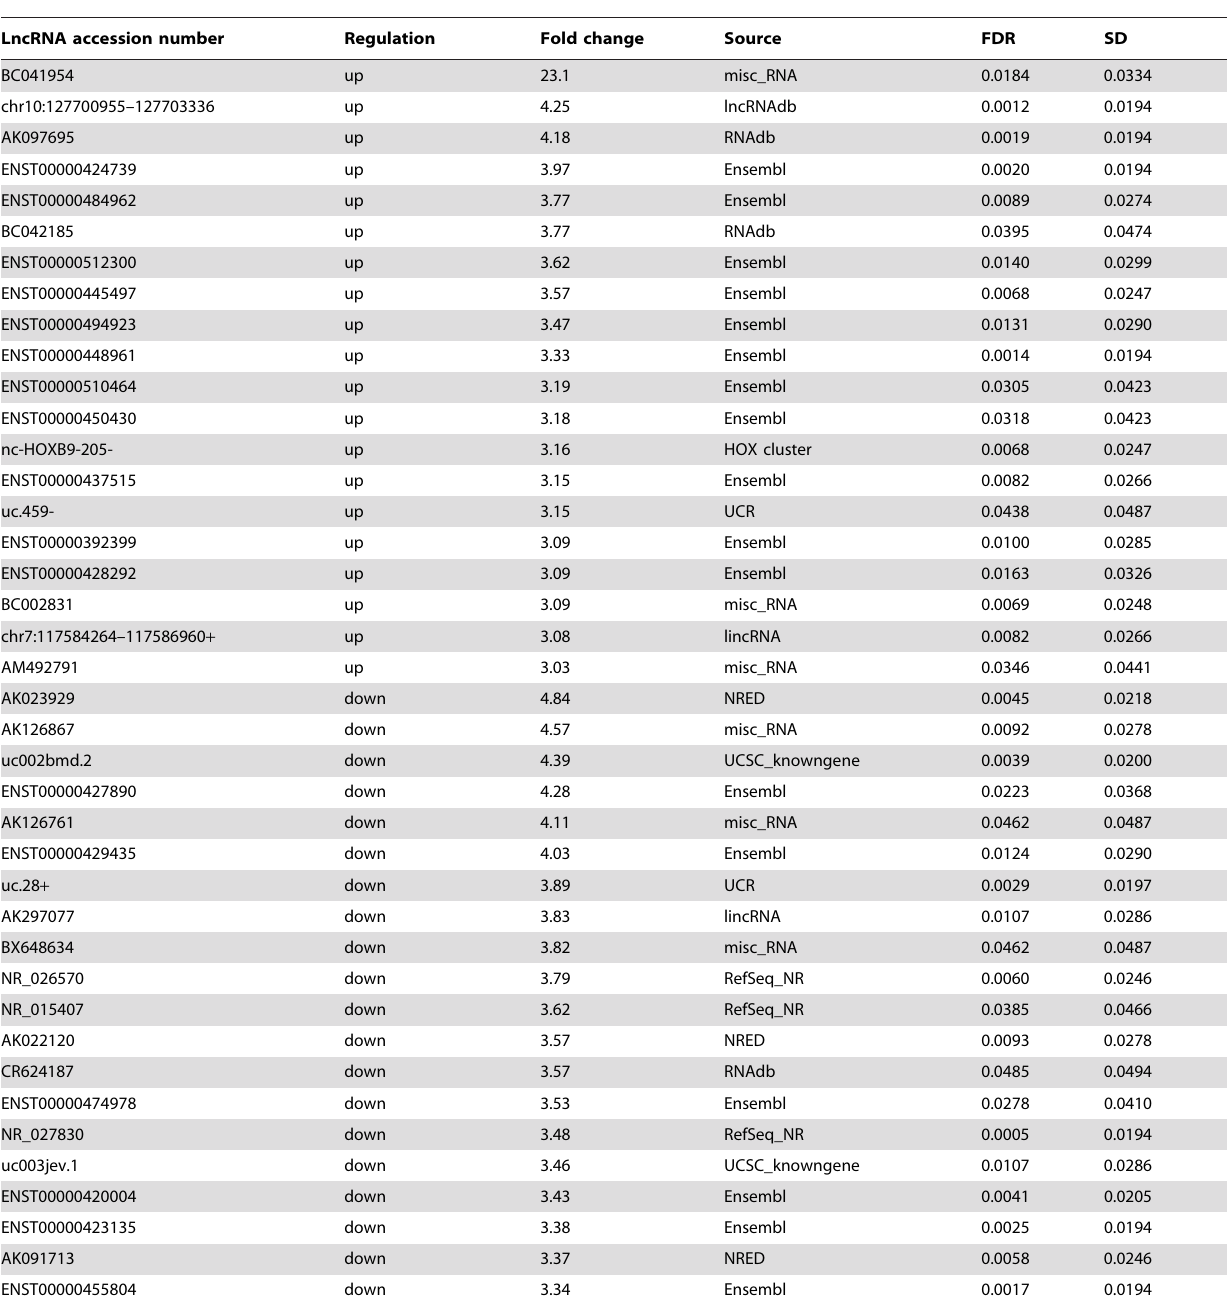
Table 3. Top 20 significantly differential expressed LncRNAs from the microarray